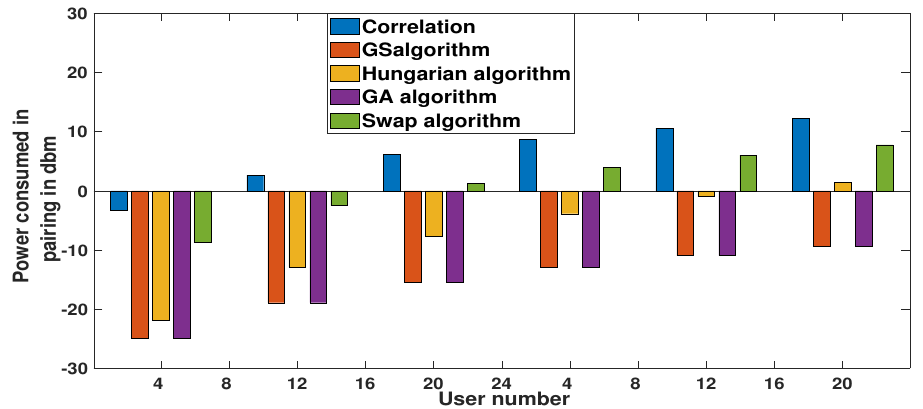
Figure 6. Power consumed in user paring in dBm versus user number, with A = 36 BS